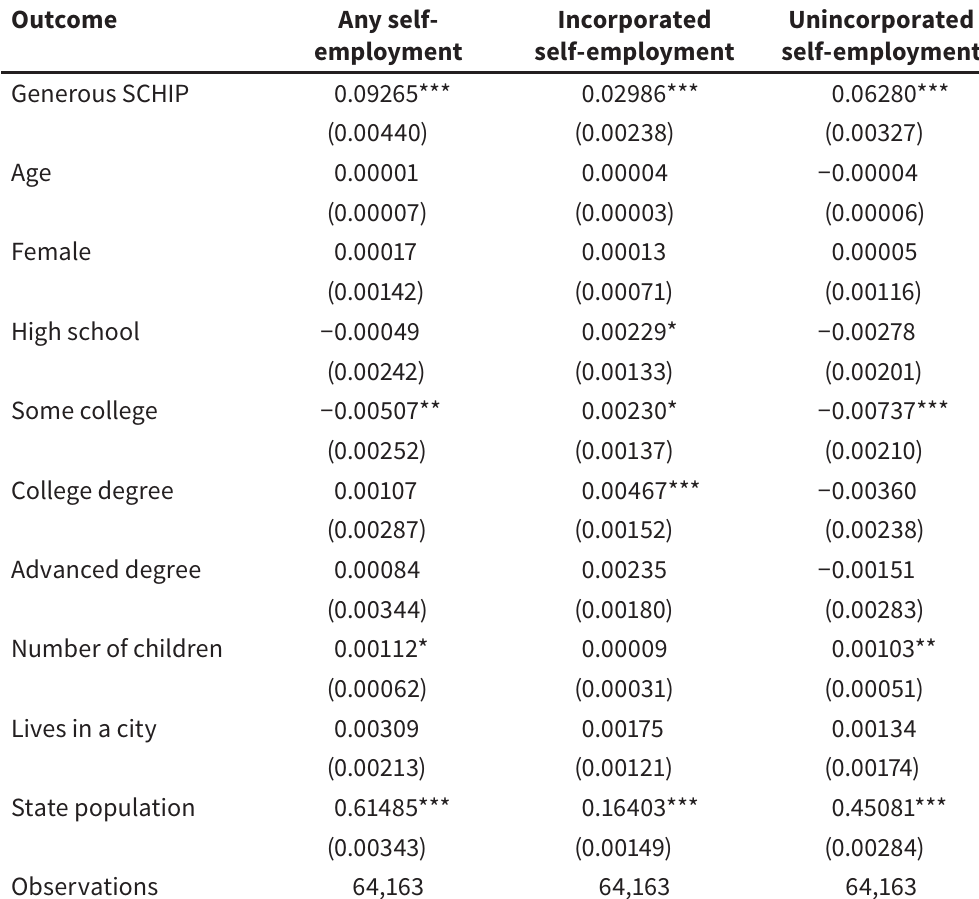
Heterogeneity in the Impact of Immigrant Entrepreneurs across Races of